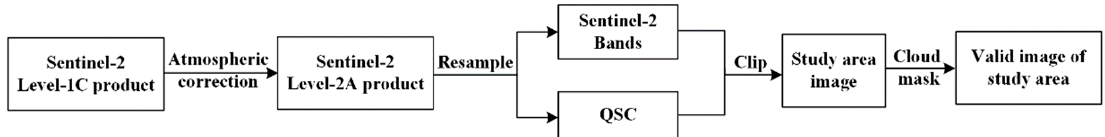
Figure 6. The preprocessing flow of Sentinel-2